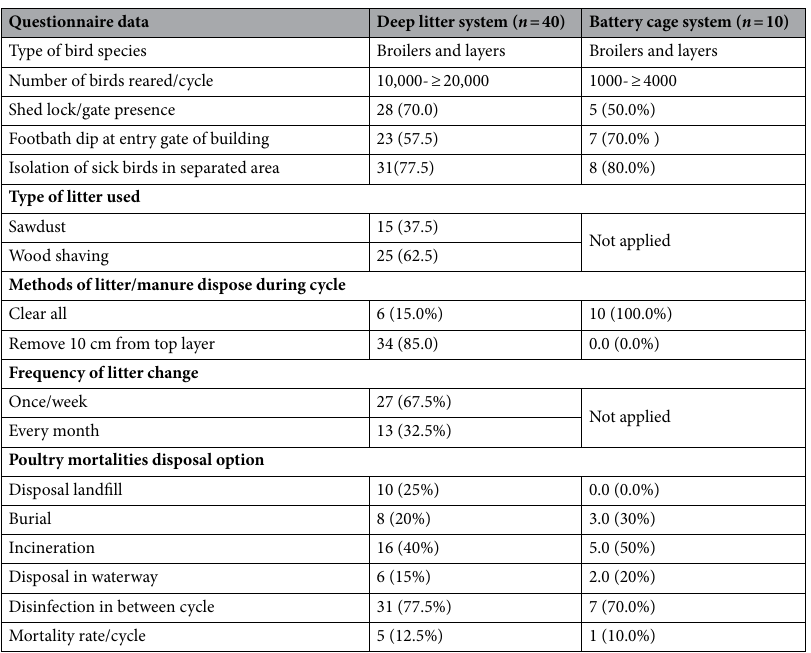
Table 1. The obtained data of structured questionnaire disseminated to the investigated poultry farms. The obtained data of disseminated questionnaire in poultry systems are significantly different at P <